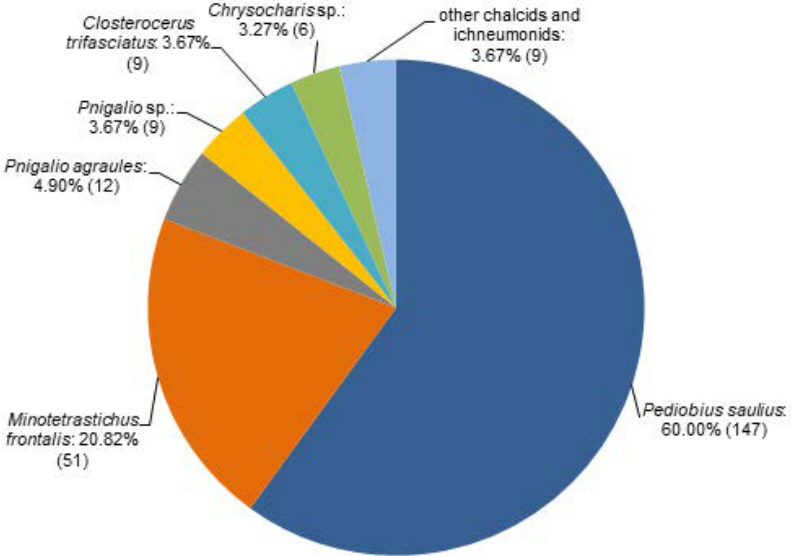
Figure A1. Parasitoid complex of C. ohridella at the six sites in the Czech Republic from 2006 to 2010. Numbers in brackets indicate absolute